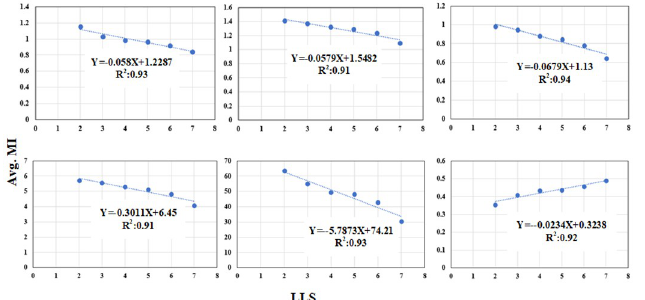
Fig 10. The linear association between LLS rating and Average MI derived for vegetation index a) NDRE, b) SAVI c) DVI d) LAI e) SR and f) REVI. Note the MI is averaged based on the LLS manual rating measured on DAP-112.